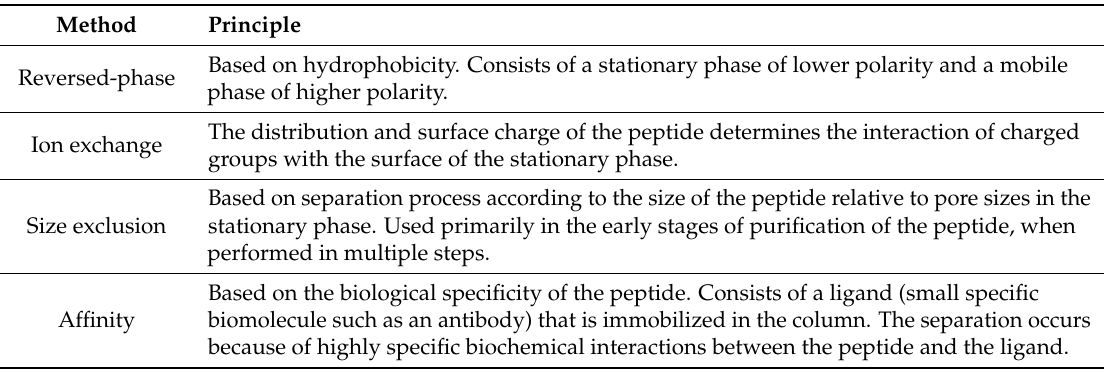
Table 3. Principles of the chromatography methods used for bioactive peptide